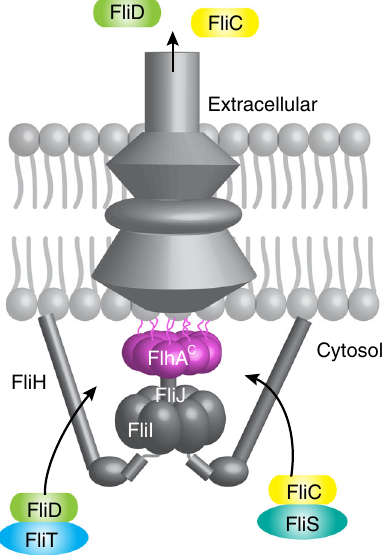
Fig. 1 A simpli fi ed schematic of the fl agellum that includes the proteins studied in this work. For detailed view, see refs. 5